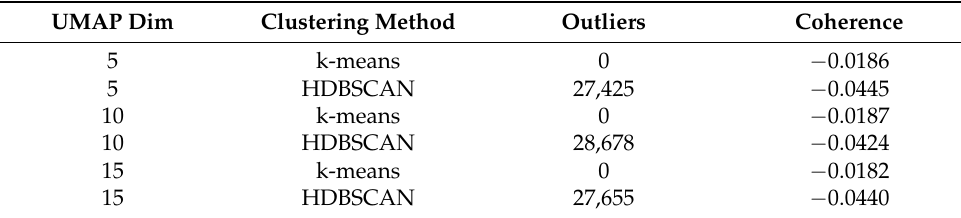
tence-t5-xxl as the sentence embedding model and 50 as the number of topics.